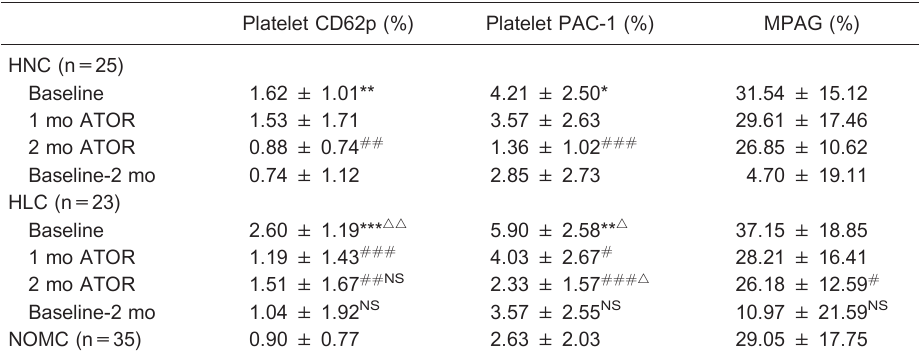
HNC: high levels of LDL-C combined with normal levels of HDL-C; HLC: high levels of LDL-C combined with low levels of HDL-C; NOMC: normocholesterolemic; mo: month; ATOR: atorvastatin; MPAG: maximal platelet aggregation. *P , 0.05 vs control; **P , 0.01 vs control (NOMC); ***P , 0.001 vs NOMC; # P , 0.05 vs baseline; ## P , 0.01 vs baseline; ### P , 0.001 vs baseline. NS: not significant vs HNC, n P , 0.05